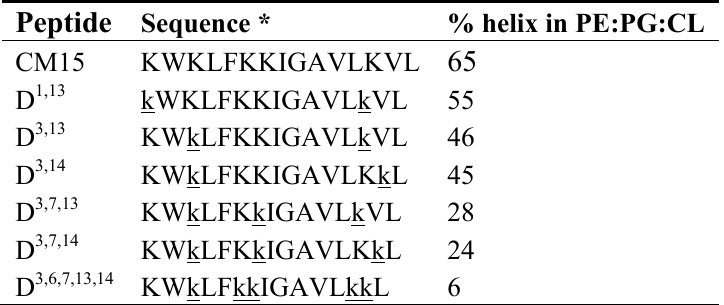
Table 1. Peptide designations and helical secondary structure content. * D-amino acids are in lower case and underlined. All peptides were N-terminally acetylated and C-terminal